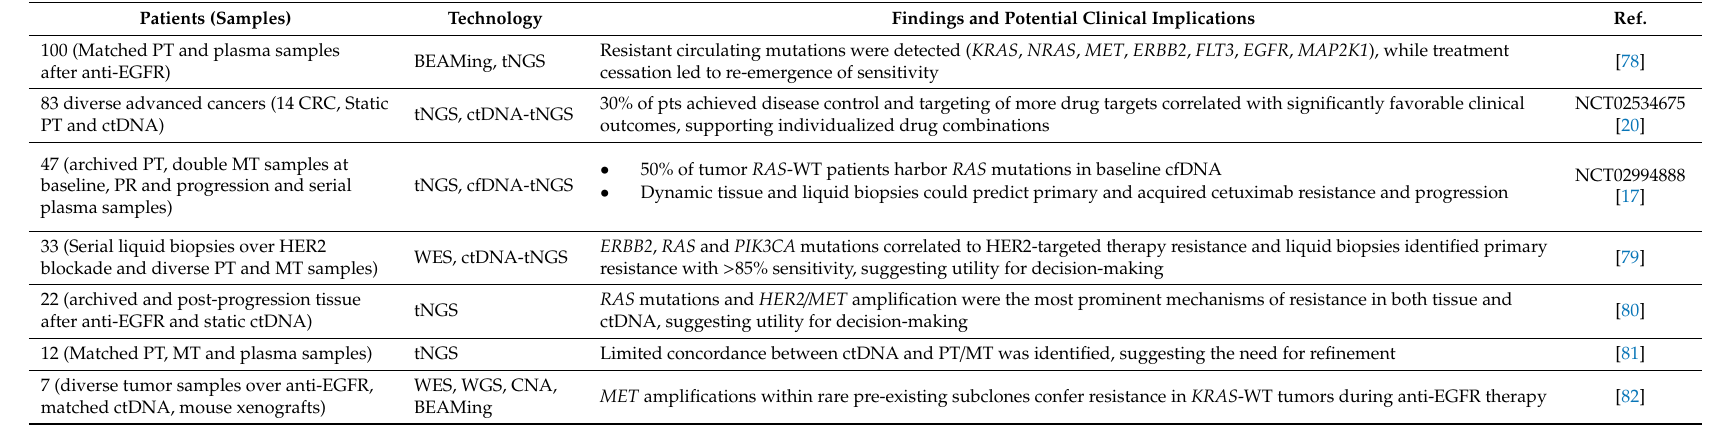
Table 4. Dynamic emergence of tumor heterogeneity and metastasis: clinical implication of intra-patient